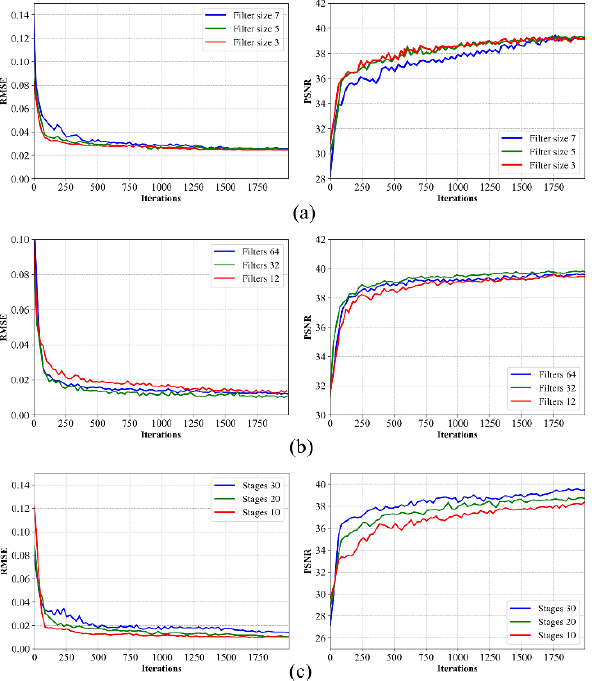
Figure 9. Model structure selection based on quantitative measures of the RMSE and PSNR as evaluated on the test dataset during training: ( a ) filter size; ( b ) number of filters; ( c ) number of stages.